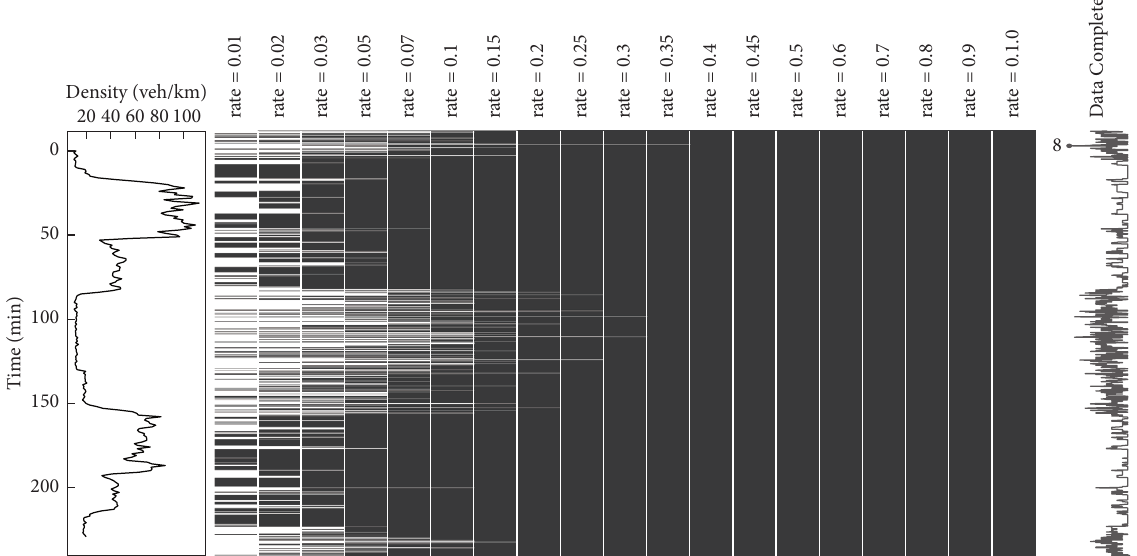
Figure 3: Vacant data of different penetration rates and density distribution map.